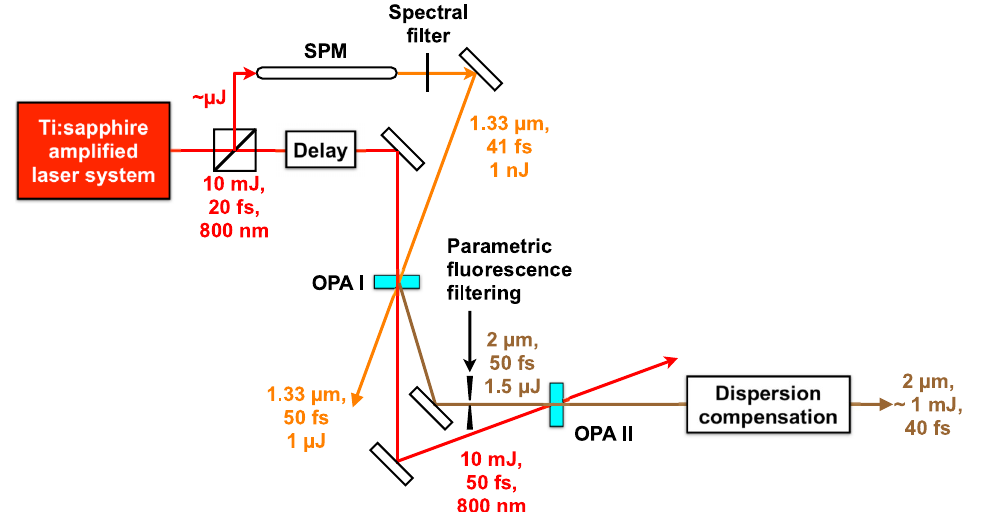
FIG. 2. Nondegenerate 2 (cid:1) m OPCPA system pumped by a standard Ti:sapphire ultrafast laser system that consists of two stages. The first stage is seeded with a Gaussian beam in both space and time; the spectrum is also assumed to be Gaussian with no incident chirp. Since the first stage is unsaturated the output beam is Gaussian in both space and time as well. The second OPA is saturated and will be seeded with a pulse having a transverse shape of a super-Gaussian as well as a chirp that will be compensated after amplification using a dispersion compensation